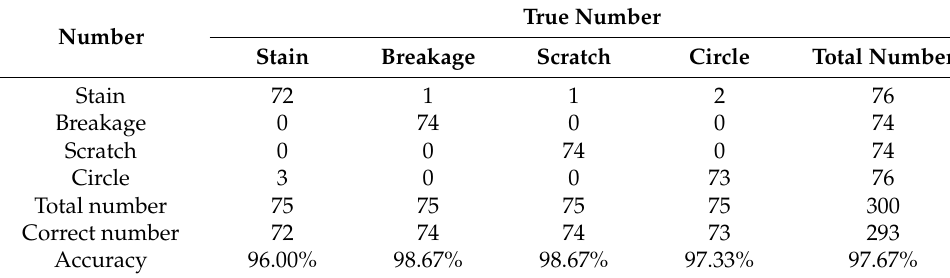
Table 6. Accuracy analysis of images generated through